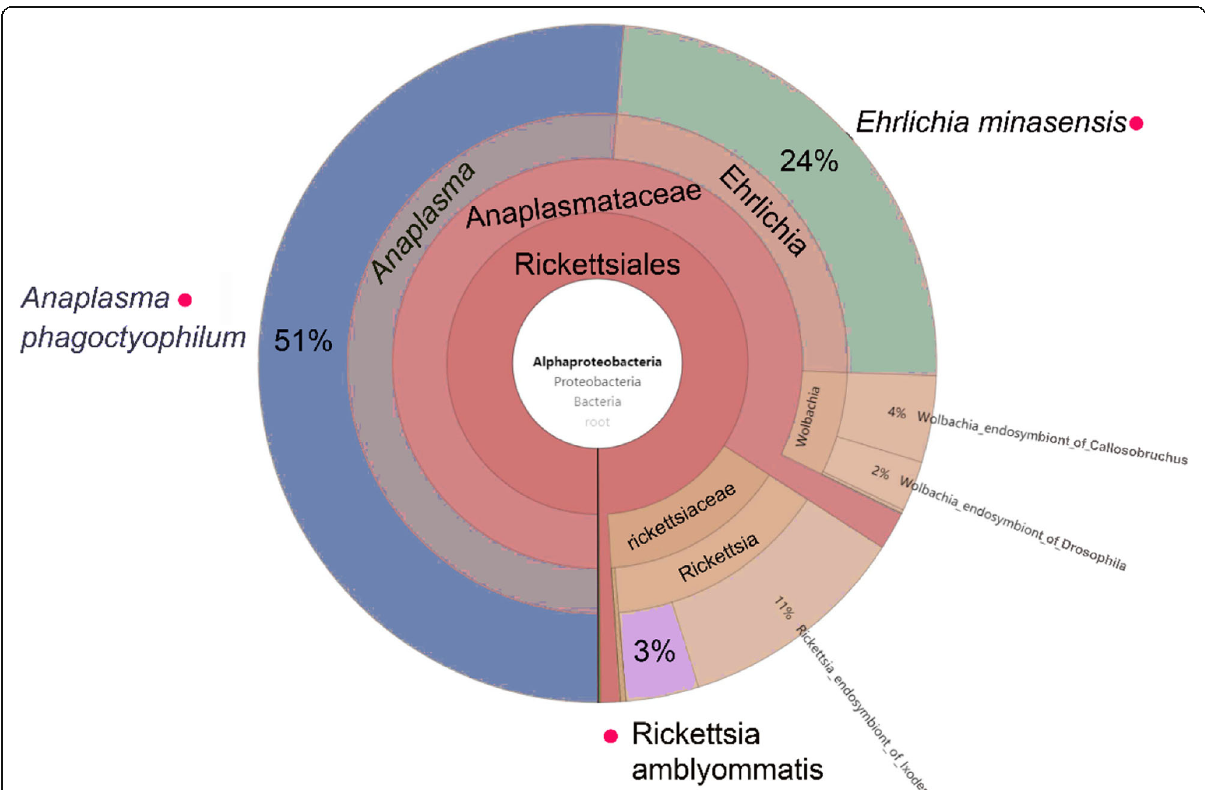
Fig. 2 Hierarchical classification and distribution of various species belonging to Alphaproteobacteria detected in the tick specimen using KRONA extension. The red dots indicate pathogens that can infect